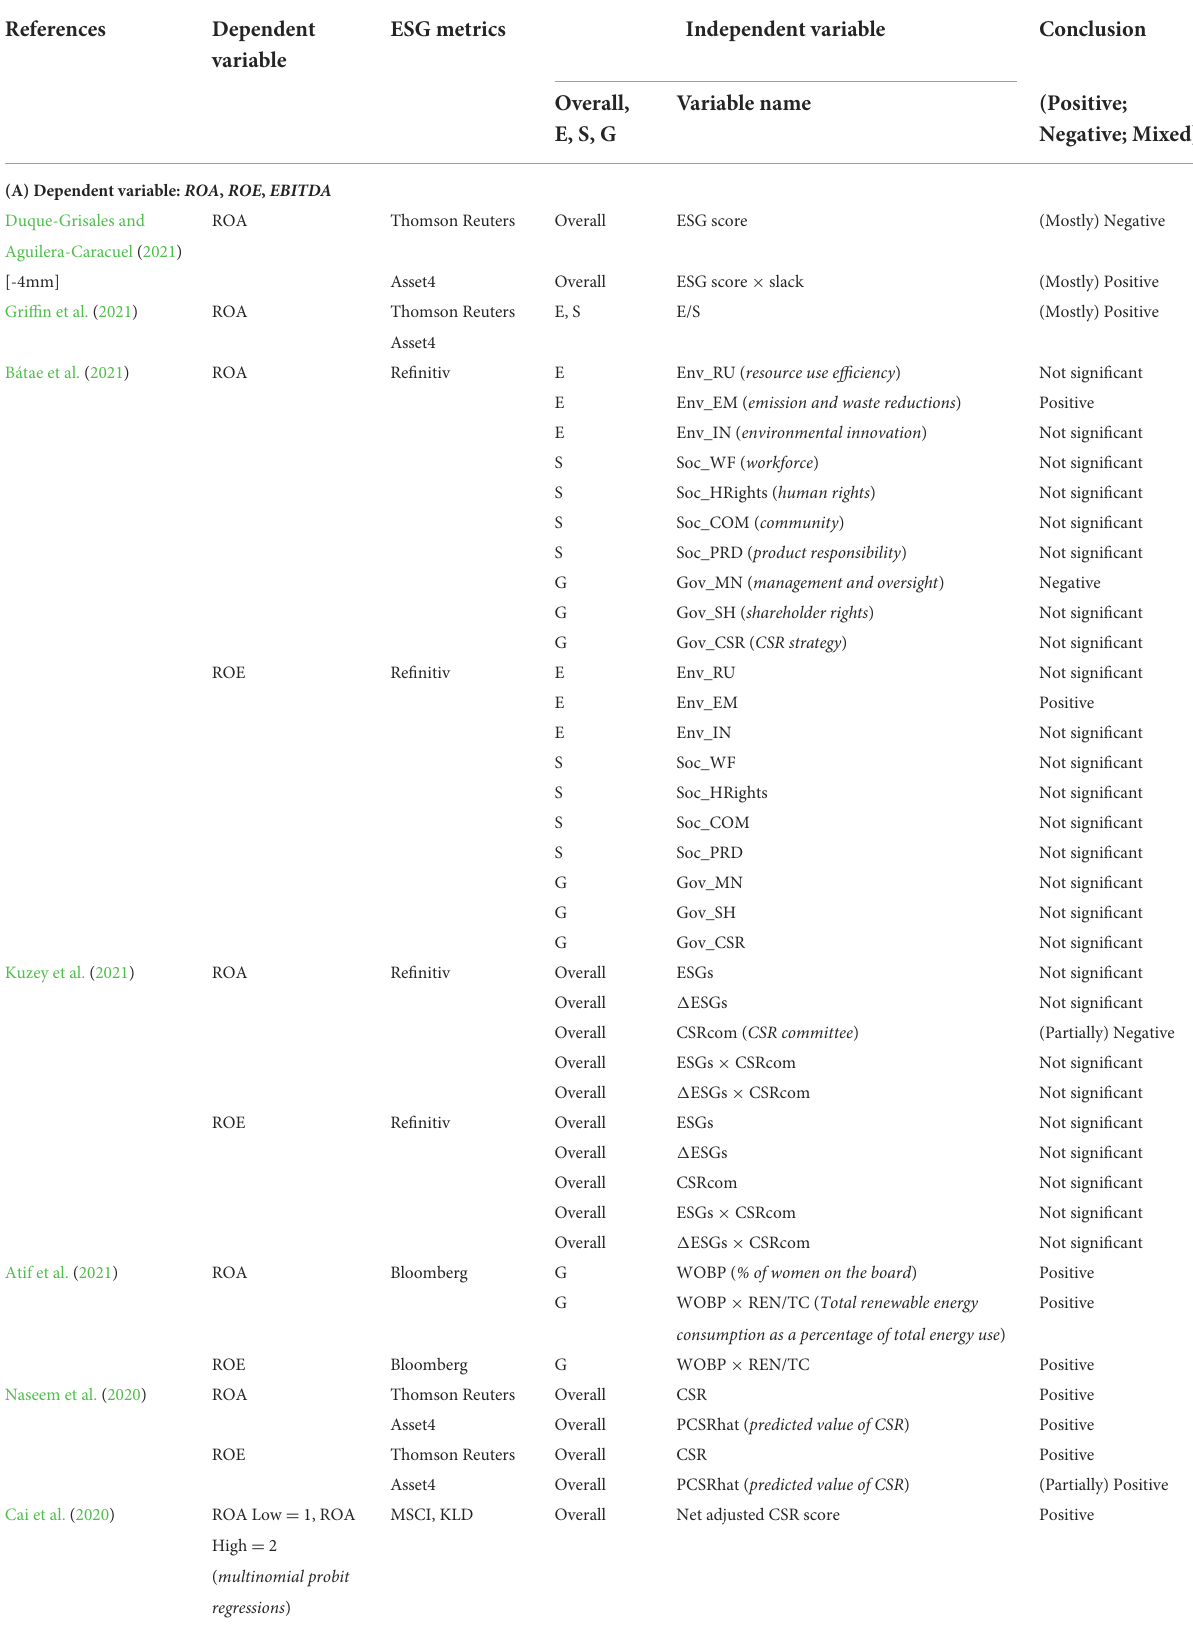
TABLE 1 List of studies using ESG metrics